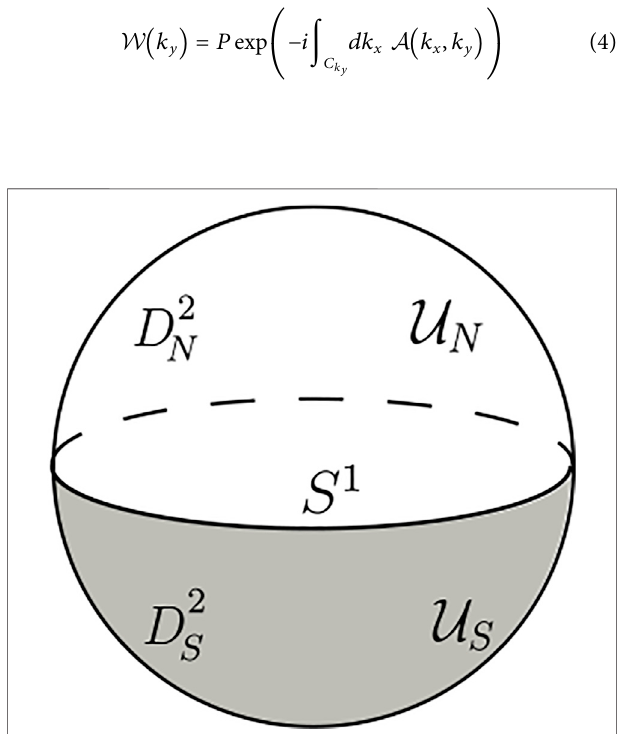
FIGURE 2 | The Takagi factors in 2D. D 2 S and D 2 N represent the south hemisphere and north hemisphere respectively, the overlapping region is equator S 1 . U N / S is the Takagi factors over D 2 N / S